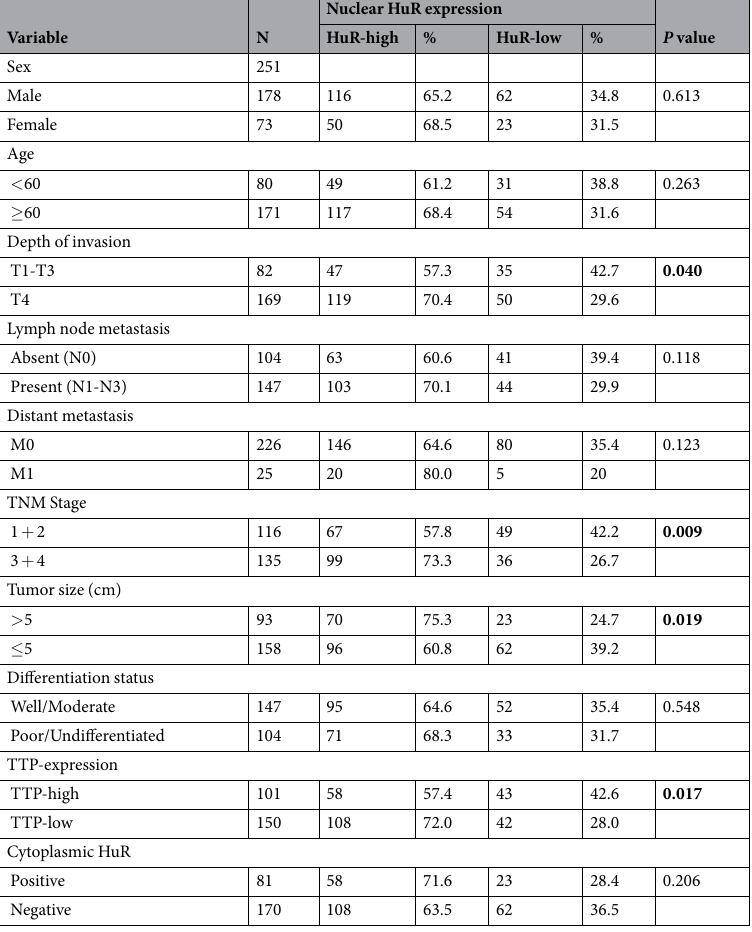
bind to AU rich elements and its optimum binding sequence is the AUUUA motif flanked by additional uridylate residues, whereas HuR can bind to the AU-, CU- and U-rich elements of target mRNAs. Dysregulation of the TTP-HuR axis may increase a series of pro-tumorigenesis factors that are associated with the development and progression of several of cancers, which we have previously reviewed 3 . An aberrant TTP-HuR axis is associated with proliferation, apoptosis, angiogenesis, metastasis, invasion, and resistance to chemotherapy. For example, elevated HuR in GC facilitated DNA synthesis, the G 1 to S phase transition of cell cycle and acted as an anti-apoptotic factor 30 . And HuR interacts with the 3 ′ UTR of matrix metalloproteinase 9 (MMP-9), urokinase plasminogen activator (uPA) and its cell surface receptor uPAR to increase cancer invasion ability. TTP is a regulator of MMP-1, -2, -9, uPA/uPAR and other factors which play important roles in tumor metastasis 3,11 . Our previous work has demonstrated that TTP is downregulated in GC. Decreased expression of TTP is closely related to the depth of invasion, TNM stage, lymph node metastasis and survival in GC patients. Restoring TTP expression in GC cells inhibits the proliferation, invasion and migration of cancer cells 16 . In this study, elevated expression of HuR and aberrant cytoplasmic translocation were observed in GC. Using immuno- histochemistry staining, we found that both positive cytoplasmic localization and elevated nuclear HuR expres- sion were closely related to poor clinicopathological features and survival of GC patients. Furthermore, we observed that dysregulation of TTP and HuR induced elevated expression of HMGB1 in different ways. Increasing evidence indicates that HMGB1 is a multifunctional factor with diverse biological functions that depend on the context, modification and its location. As a non-histone chromosomal protein in the nucleus, HMGB1 participates in DNA replication, repair, and transcription. Elevated HMGB1 in the cyto- plasm and extracellular environment is associated with a variety of activities, including inflammation, autophagy, anti-apoptosis, proliferation, metastasis, among others 31 . HMGB1 plays a paradoxical role in cancers. It acts as both a cancer-promoter and a tumor-suppressor 19 . For example, acting as an anti-tumor factor, intracellular HMGB1 sustains autophagy and stabilizes the genome. Overexpressed HMGB1 in breast cancer was reported to bind to the tumor suppressor Rb and induce cell cycle-arrest and apoptosis 32 . However, extracellular HMGB1 interacts with different receptors, including RAGE, TLR-2, and TLR-4, and acts as a cytokine, chemokine, and